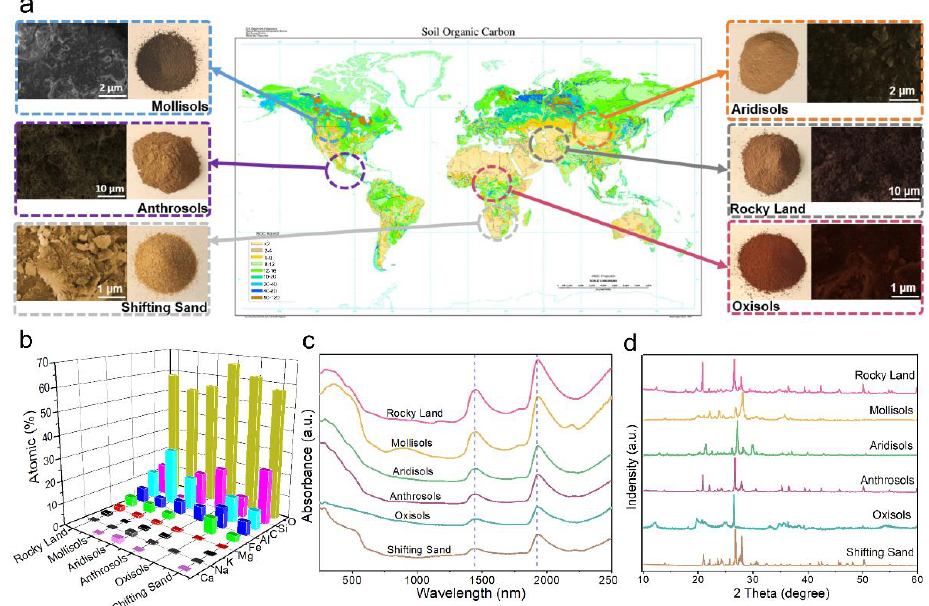
Figure 1. ( a ) -Photos and scanning electron microscope (SEM) images of six soils and their main distribution in the global soil organic carbon map; ( b ) Energy dispersive spectrum (EDS) analysis of the six soils (the atomic percentage of the major elements); ( c ) X-ray diffraction spectra (XRD) of the six soils; ( d ) Absorbance spectra in the wavelength range of 250–2500